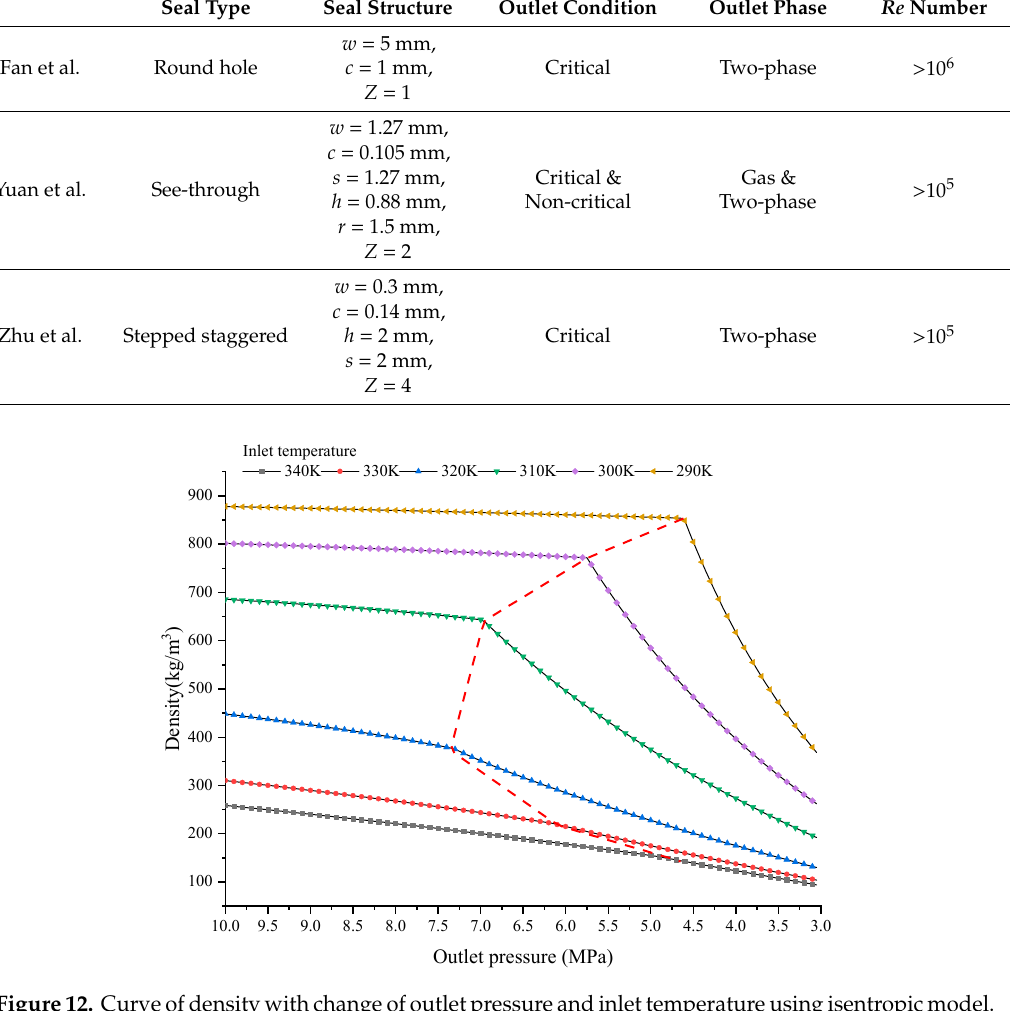
Figure 12. Curve of density with change of outlet pressure and inlet temperature using isentropic model.